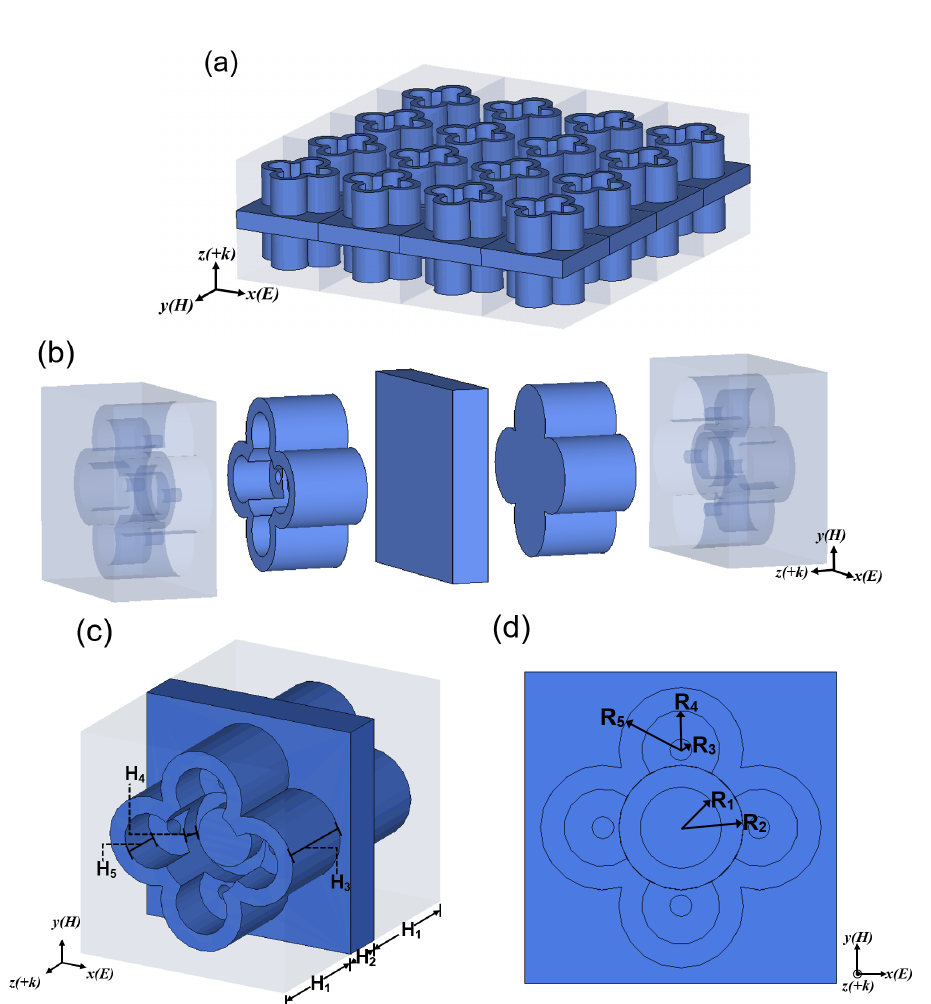
Figure 1. ( a ) Schematic of the MA; ( b ) structure profiling diagram; ( c ) side view; ( d ) positive view. Table 1. The Specific Value of Geometric Parameters.